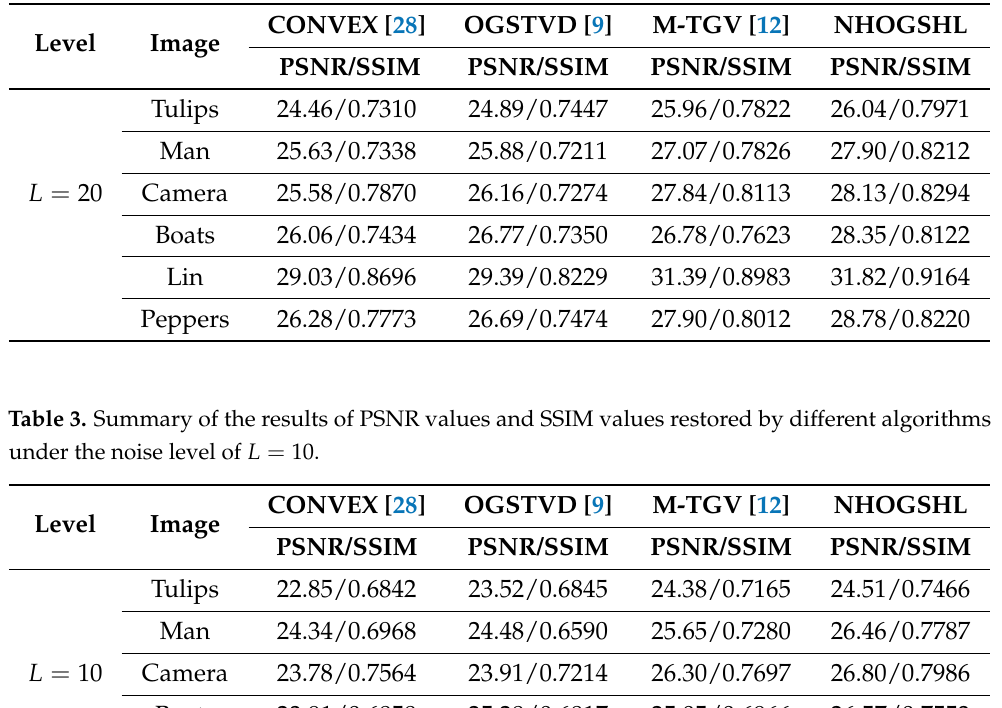
Table 2. Summary of the results of PSNR values and SSIM values restored by different algorithms under the noise level of L = 20.